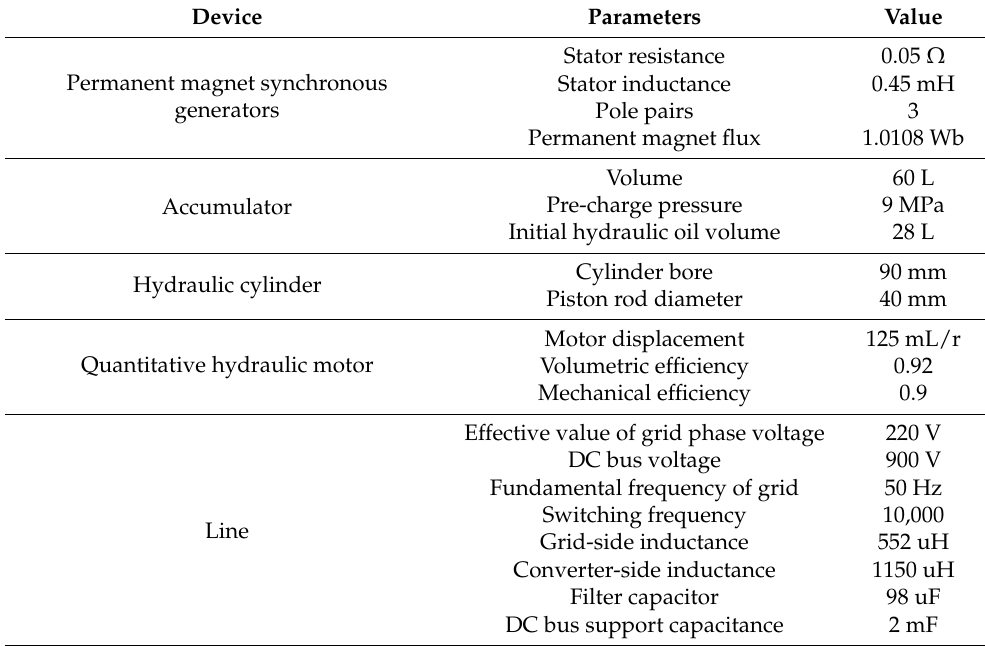
Table 2. System Simulation